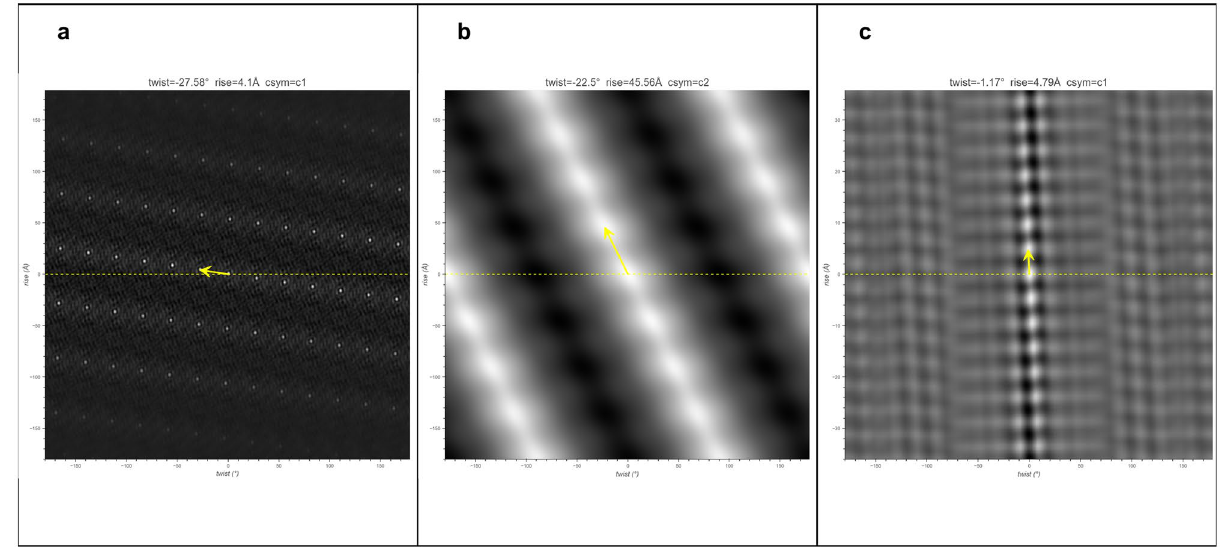
Figure 3. HI3D results for three helical structures in EMDB. ( a ) EMD-30129 (Helical stem of the cleaved double-headed nucleocapsids of Sendai virus, 2.9 Å); ( b ) EMD-1759 (Bacterial tubulin homologue TubZ, 35 Å, reconstructed from negative stain EM images); ( c ) EMD-23890 (Tau straight helical filament extracted from PrP-CAA patient brain tissue, 3.1 Å). The published rise and twist for these three datasets are (4.09 Å, ◦ ◦ − (42 Å, 21 ), and (4.79 Å, 1.07 ), respectively.